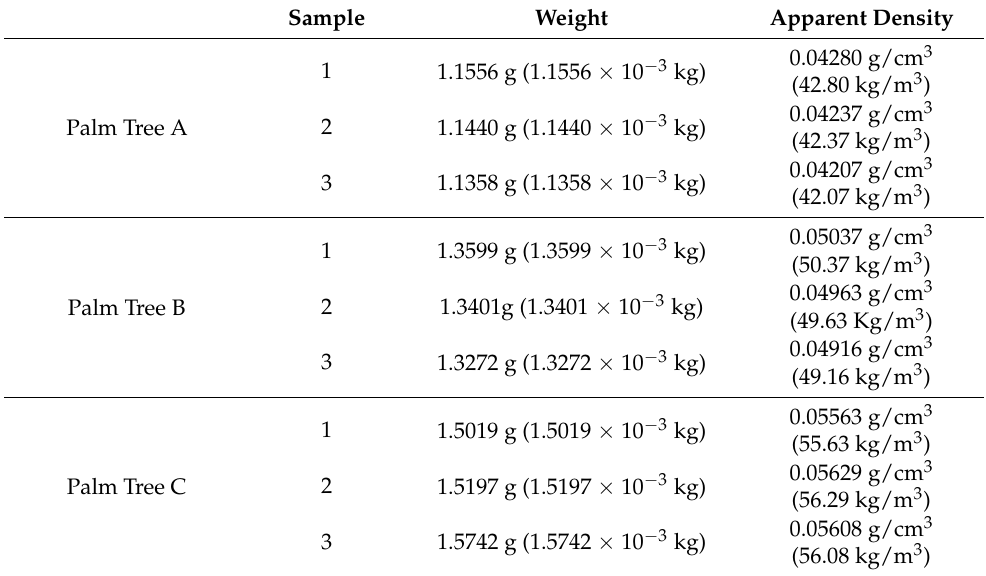
Table 3. Measurements of weight and apparent density of Buriti foam samples. Sample Weight Apparent